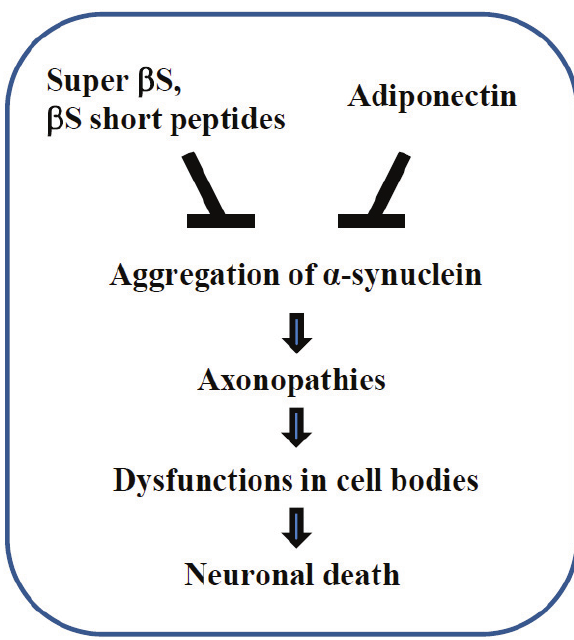
Figure 3. Therapeutic strategy against axonal pathology of (cid:2)-synucleinopathies. Modified forms of (cid:3)S, such as “super” (cid:3)S and “short peptides” derived from (cid:3)S; please see the main